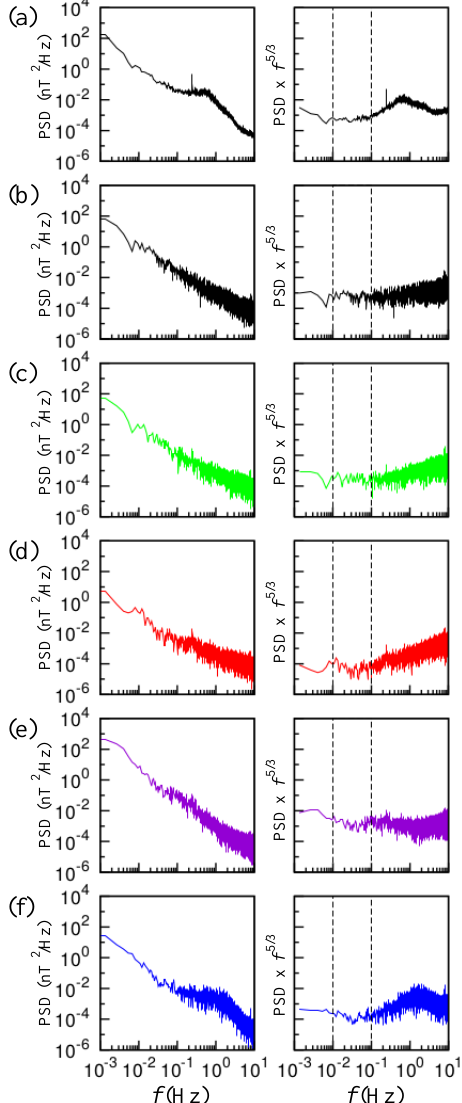
Figure 4. The power spectral density (PSD, left panels) and the compensated PSD (right panels) for (a) the time series of | B | from 00:32UT until 08:40UT, (b) the IMFR-1 interior region, (c) the interface between IMFR-1 and IMFR-2, (d) the IMFR-2 interior region, (e) the interface between IMFR-2 and IMFR-3, and (f) the IMFR-3 interior region. Vertical dashed lines indicate the beginning and the end of the inertial subrange.